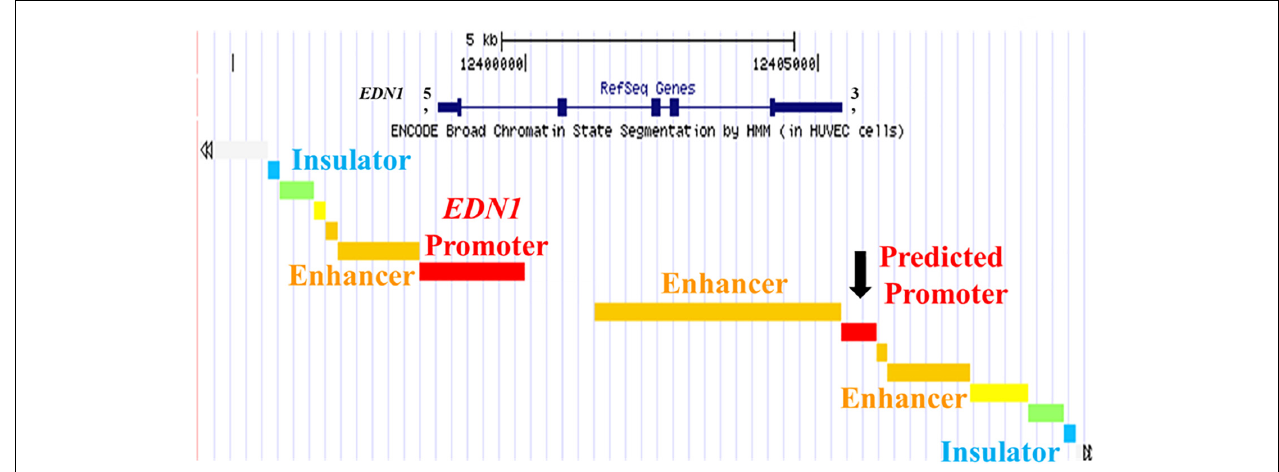
FIGURE 1 | UCSC Genome Browser Predicts Promoter in 3 (cid:48) UTR of EDN1 Gene. The University of California Santa Cruz (UCSC) Genome Browser with ENCODE broad chromatin state segmentation by HMM in human umbilical vein endothelial cells (HUVEC) cells shows a predicted promoter (black arrow) in the 3 (cid:48) untranslated region (UTR) of the EDN1 gene. The EDN1 gene is shown at the top (navy blue) with boxes representing exons. The EDN1 gene position is aligned with the genome segments in the ENCODE broad chromatin state track.